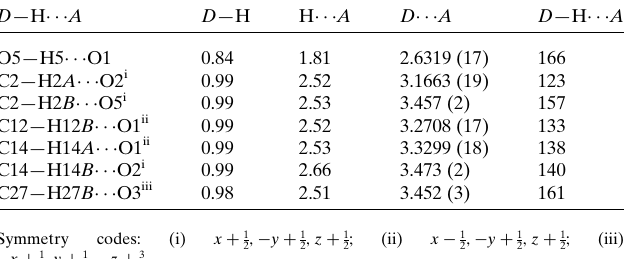
Table 1 Hydrogen-bond geometry (A˚ , (cid:3) ).